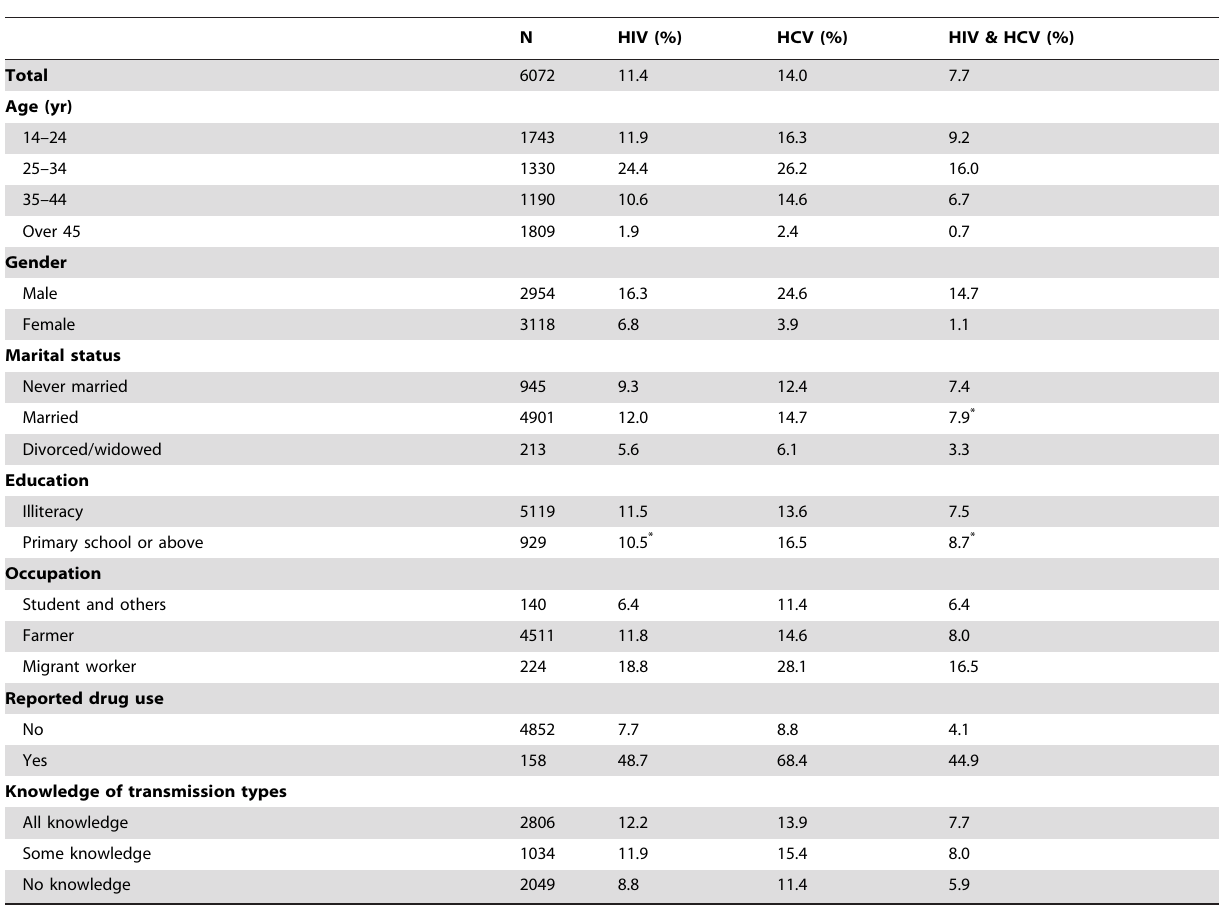
Table 2. Chi-square analysis of HIV and HCV prevalence in the study